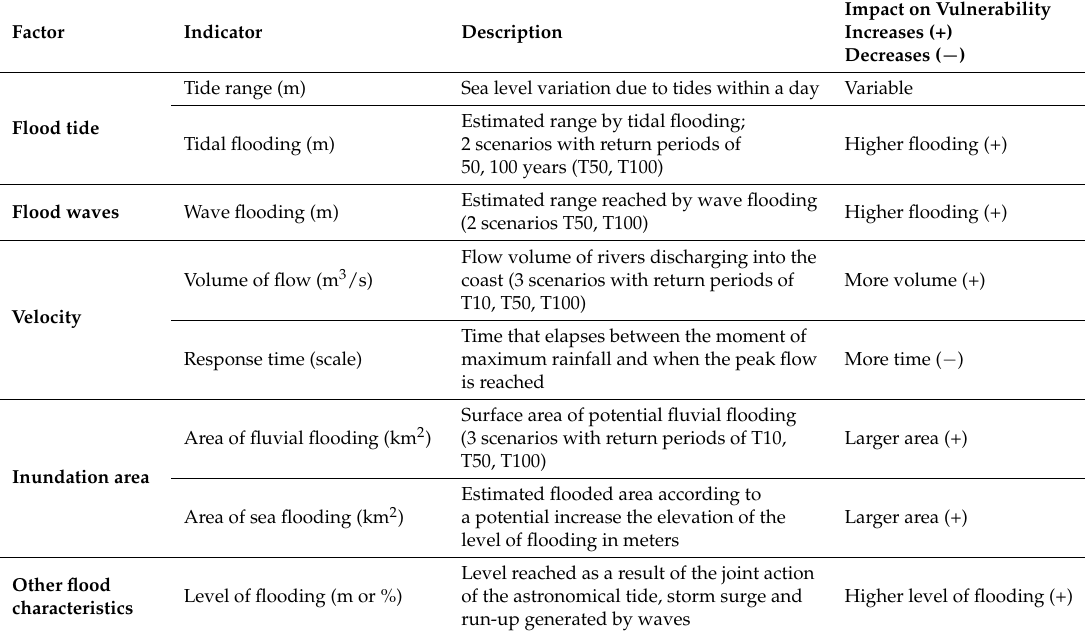
Table 2. Table 2. Exposure indicators of flood